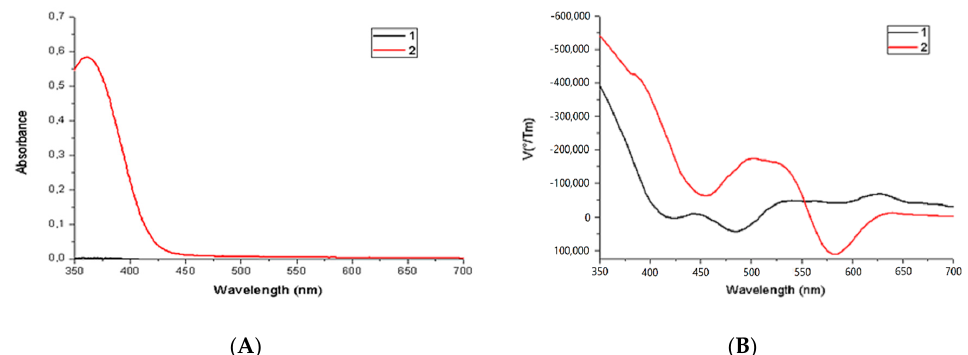
Figure 3. ( A ) and Faraday rotation spectrum ( B ) of 1 and 2 .